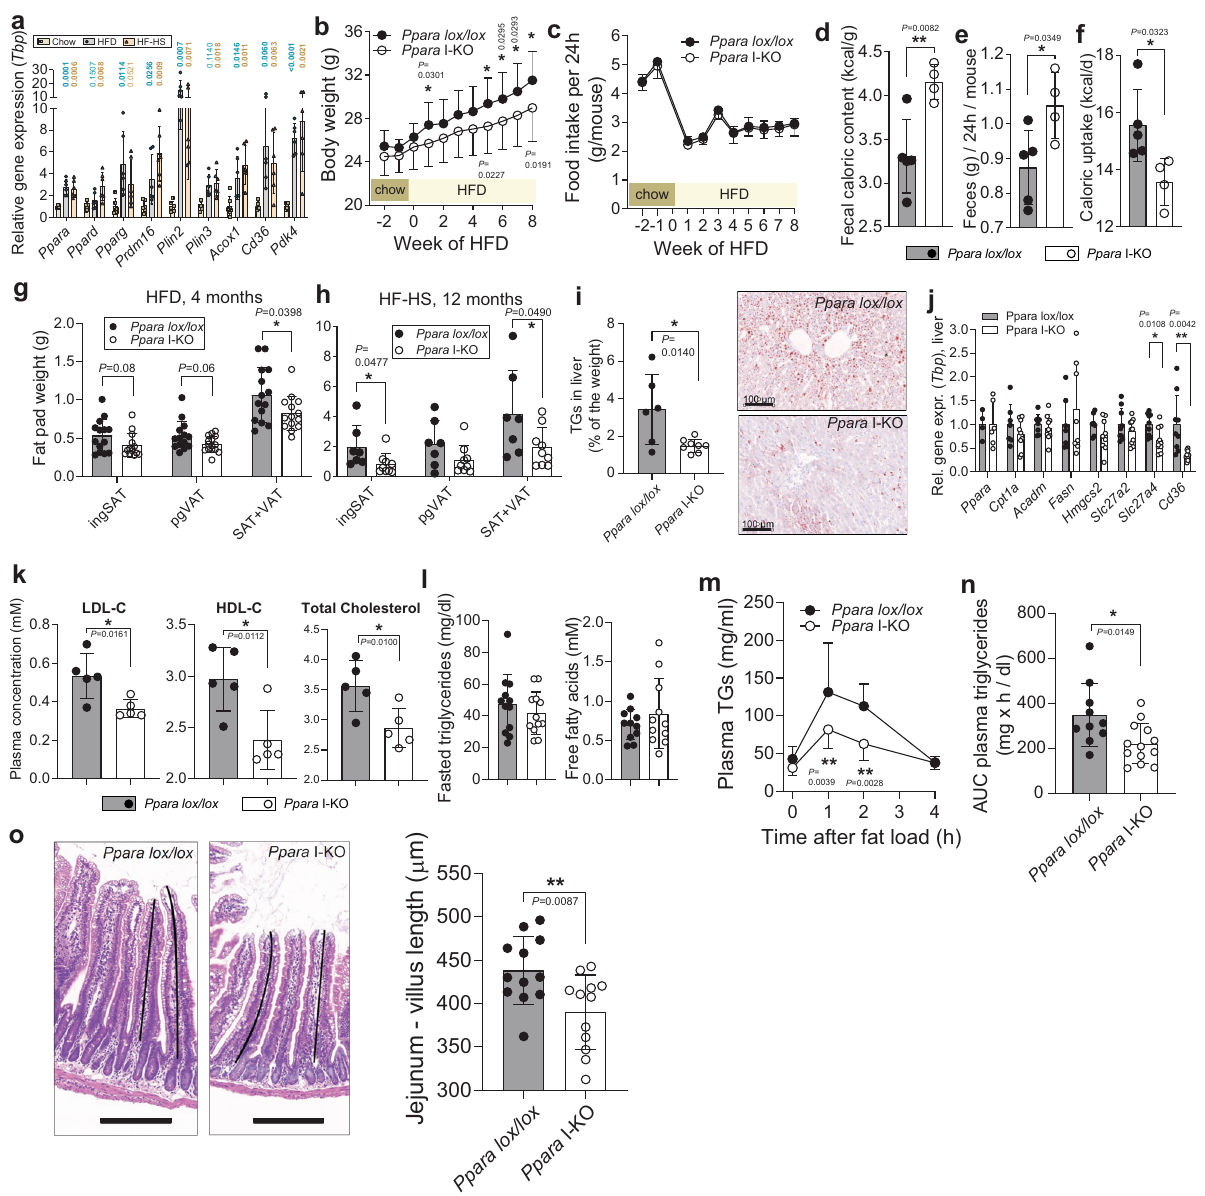
Fig. 3 Ppara intestinal KO reduces adiposity, caloric uptake and postprandial lipidaemia on HFD. a Relative gene expression (qPCR normalized to Tbp ) in proximal jejuna of WT C57BL6/J mice on ad libitum chow, HFD and HF-HS ( n = 6 mice per group). b Body weight development of Ppara lox/lox ( n = 17), Ppara I-KO ( n = 15) on HFD. c Daily food intake per mouse, n = 5 cages per group, two mice per cage on HFD. d – f Caloric density of faecal samples ( d ), daily fecal output ( e ), and total caloric uptake (calories from food − excreted calories) ( f ) in HFD mice, n = 5 (lox/lox) or four (I-KO) independent samples, where each sample is a pool of 48 h faeces from two mice in a single cage. g – h Fat pad weights, after four months of HFD ( g ), n = 14 mice per group from two independent experiments, and after 12 months of HF-HS diet ( h ), n = 7 (lox/lox) or 9 (I-KO) mice, ingSAT inguinal subcutaneous, pgVAT perigonadal visceral adipose tissue. i Triglyceride content in liver, n = 6 ( lox/lox ) or eight (I-KO) mice, and representative Oil red O staining of the liver cryosection, scale bar = 100 μ m. j Relative gene expression (qPCR normalized to Tbp ) in the liver of n = 4 – 9 (lox/lox) or 6 – 9 (i-KO) mice pooled from two independent experiments. k LDL, HDL and total cholesterol in plasma of fasted mice, measured by Cobas C111 platform, n = 5 mice per group. l Triglycerides ( n = 12 mice per group) and free fatty acids ( n = 11 mice per group) in plasma of fasted mice. m , n Plasma triglyceride levels after oral administration of 100 μ l of olive oil ( m ) and corresponding area under the curve ( n ), Ppara lox/lox n = 10, I-KO n = 13. o Representative H&E staining and villi tracing, scale bar = 200 μ m, and average jejunum villus length from n = 12 mice per group ( o ). b – o Ppara lox/lox and Ppara I-KO are male mice on